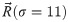
Schematics showing possible variations of SC features and illustration of the Cellular Potts Model for simulation.A Confocal images of ♂ wt (male wildtype) SC (labelled green) at 23 and 36 hours after pupariation. Each scale bar: 20 μm. B Schematic showing the rotation of SC. C Schematics showing three hypotheses for SC rotation: the push model (left) where SC rotates due to the force generated by the expanded distal cells, the pull model (centre) where SC rotates due to the pulling force generated by the contraction of proximal cells, and the push and pull model (right) where SC rotates due to both the pushing and pulling forces from the cells distally and proximally. D Schematics showing possible variations in SC orientations during evolution (top). Images of adult legs of Drosophila species that exemplify these variations (bottom). Each scale bar: 20 μm. E Schematics showing some possible variations in SC shapes during evolution (top). Images of adult legs of Drosophila species that exemplify these variations (bottom). Each scale bar: 20 μm. F Schematics showing possible variations in SC lengths during evolution (top). Images of adult legs of Drosophila species that exemplify these variations (bottom). Each scale bar: 20 μm. G Left: an example configuration of pixels in the Cellular Potts Model. Each square enclosed by dotted lines is a pixel (8 × 8 pixels in this configuration). The number inside the pixel represents the cell index label σ. Each pixel at a single time can only be labelled by one cell index. In this example there are 15 “cells” occupying 64 pixels at the current moment, and the solid lines represent “cell” boundaries. The colours of the cell index labels represent cell types c. Right: illustration of an attempted pixel label flip during a Monte Carlo step (mcs). The circled pixel on the left panel is the randomly chosen “target pixel”, and the pixel with a hexagon is the (also randomly chosen) neighbouring pixel (invading pixel). Whether there is a change to the cell index label of the target pixel is dependent on the relative effective energies of the configuration with and without the flipping. During a single mcs, there can be many such attempted pixel label flips (as specified by the parameters of the simulation–see Table 1). H Illustration of how variables θ and R are calculated for axial preference of epithelial cells. In this example, “cell” 11 is the “invading” cell (since the “invading” pixel belongs to that cell), and the “target” pixel is in cell 9. θ(σ = 11) is the angle subtended between the two vectors: the x axis and the vector R→(σ=11) that points from the centre of mass (CoM) of the “cell” 11 to the target pixel. R(σ = 11) is the norm of R→(σ=11). In this example only θ(σ = 11) and R(σ = 11) are shown. Similarly, θ(σ = 9) (not labelled in this figure) is the angle subtended between the x axis and the vector R→(σ=9) that points from the CoM of cell 9 to the target pixel, while R(σ = 9) (again not labelled in this figure) is the norm of R→(σ=9). I Left: an example initial cell configuration for a 9-tooth SC simulation. As in G and H, we use different colours to differentiate cell types (blue-EP1; magenta-EP2; yellow-EP3; green-SCT; red-BA), but the boundaries (black horizontal and vertical lines) depicted here are cell boundaries, not pixel boundaries. Right: blow-up of a selected rectangular area from the upper panel to illustrate cell types and sizes. In this magnification, there are four types of cells shown: EP1 (blue), EP3 (yellow), SCT (green) and BA (red). Cells of the same type may have different initial areas, as demonstrated by the blue EP1 cells. As an indication of the relative initial areas occupied by different cells, the (square) SC tooth marked with an “X” has an area of 6 × 6 = 36 pixels. “Proximal” refers to the region above the SC and “distal” refers to the region below the SC. Therefore, EP1 and EP2 cells are sometimes called “distal cells” but EP3 cells are sometimes called “proximal cells”.